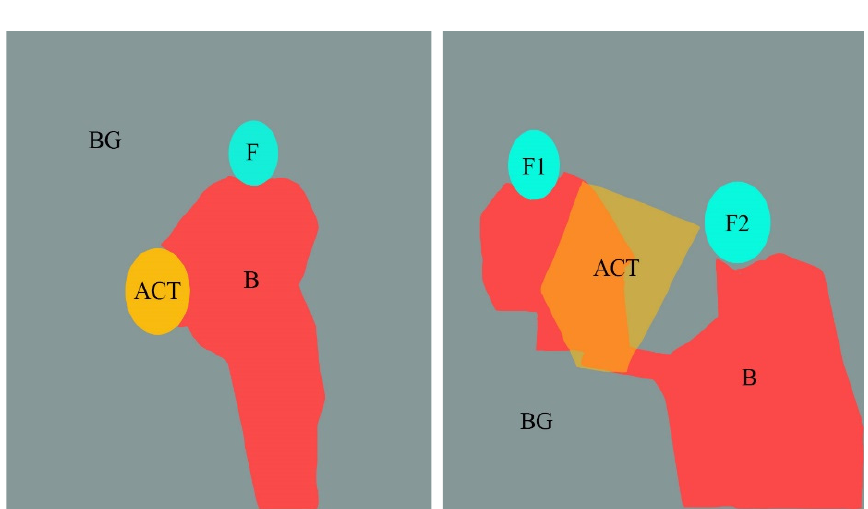
Figure 3. Division of AOI in isolated individual scene ( Left ) and social interaction scene ( Right ). (F: face AOI. B: body AOI. ACT: activity AOI. BG: background AOI). The eye tracking indicators used in the experiment included: